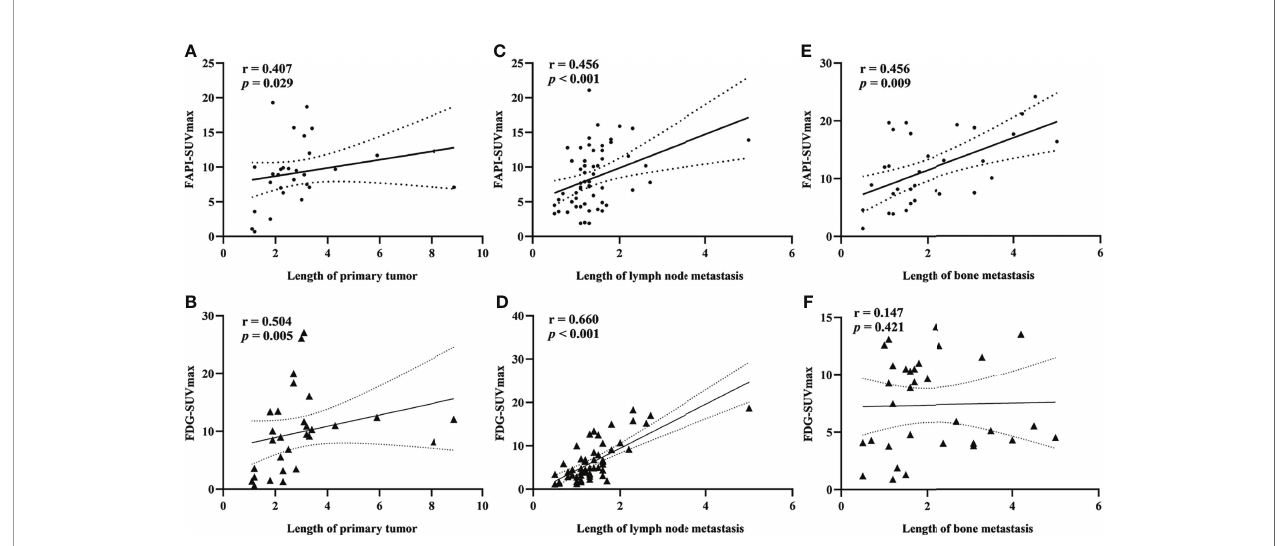
FIGURE 5 | Spearman rank correlation analysis of the relationship between SUVmax value and lesion length for primary tumors (A) . FAPI-SUVmax; (B) FDG- SUVmax), lymph node metastases (C) . FAPI-SUVmax; (D) FDG-SUVmax), and bone metastases (E) . FAPI-SUVmax; (F)